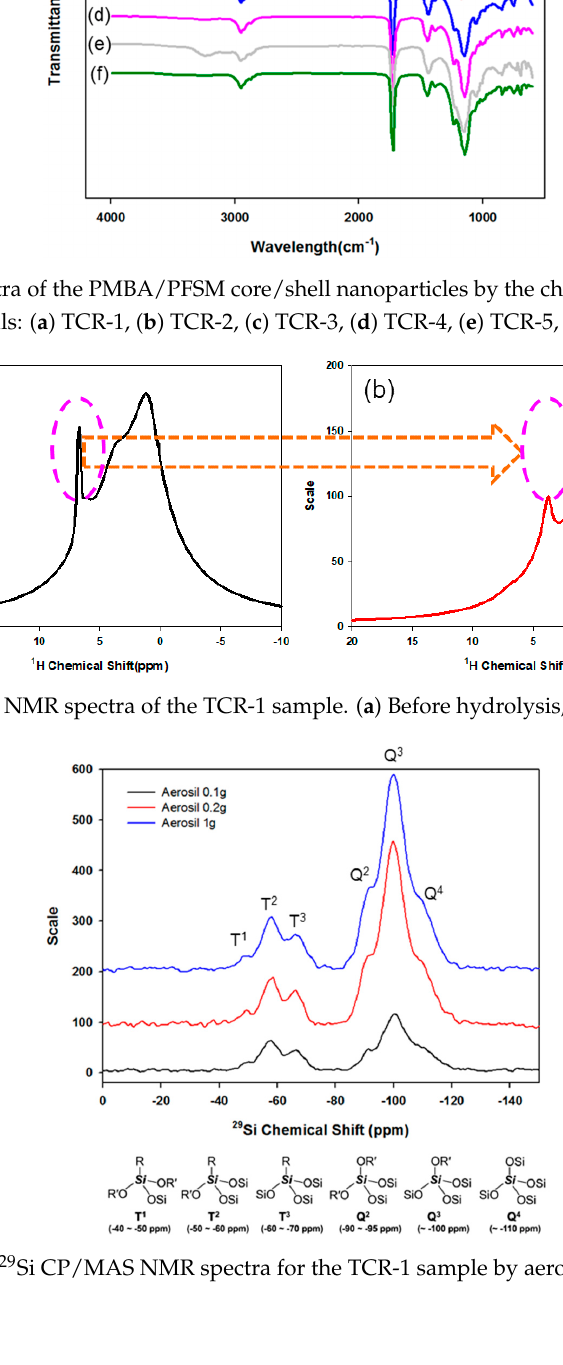
Figure 4. 29 Si CP/MAS NMR spectra for the TCR-1 sample by aerosol contents.